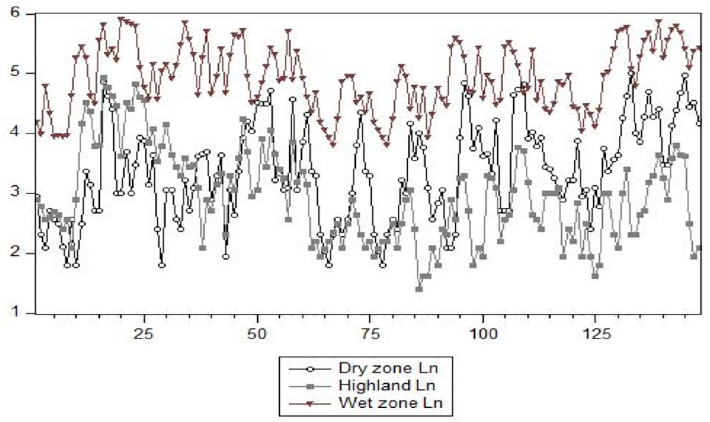
Fig 6. Monthly reported cases of leptospirosis from January 2007 to April 2019 (natural log–transformed data, Ln), by meteorological zones in Sri